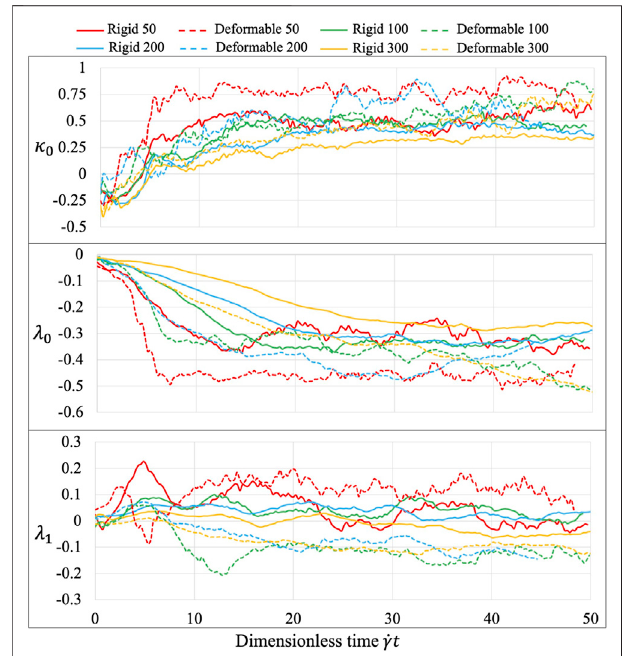
FIGURE 8 | Equation parameters for different experiments. The three introduced parameters { κ 0 , λ 0 , λ 1 } are sensitive to different shear stresses and platelet body